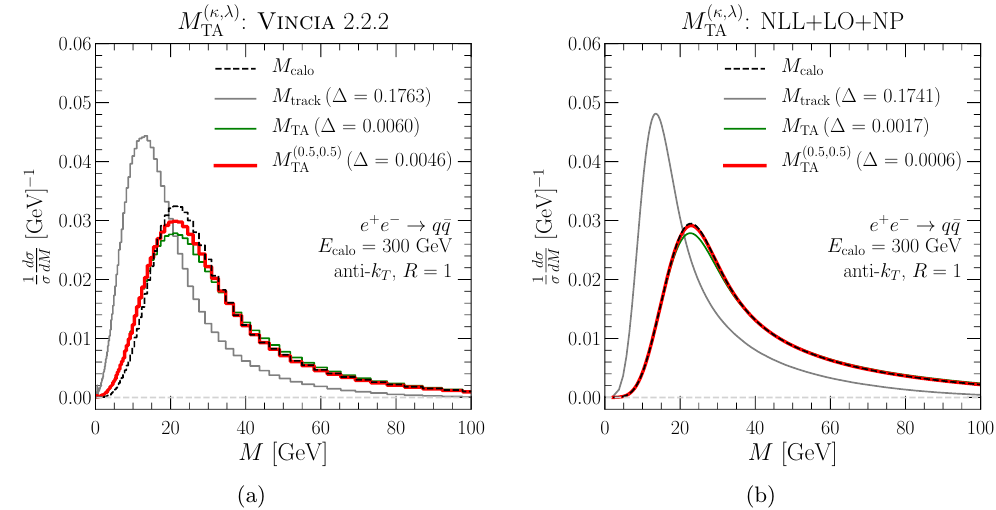
Figure 1 . Distributions of jet mass M calo and GTAM M ( (cid:20);(cid:21) ) (a) Vincia 2.2.2 and (b) NLL+LO calculations convolved with a non-perturbative shape function. The values of (cid:1) in the legend correspond to the similarity measure introduced in eq. (2.5), with small values of (cid:1) indicating a closer match to M calo